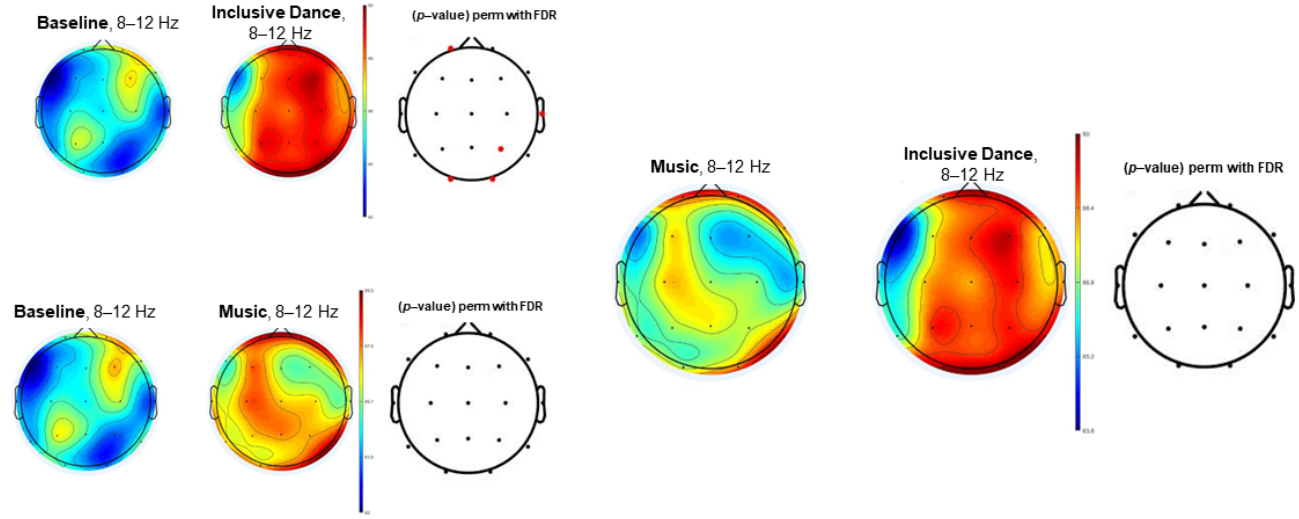
Figure 2 . EEG topographic maps in the alpha power spectrum (8–12 Hz) of the comparison between baseline, inclusive dance, and listening to music conditions. Significant comparisons ( p ‐ value < 0.05) have been highlighted in red.